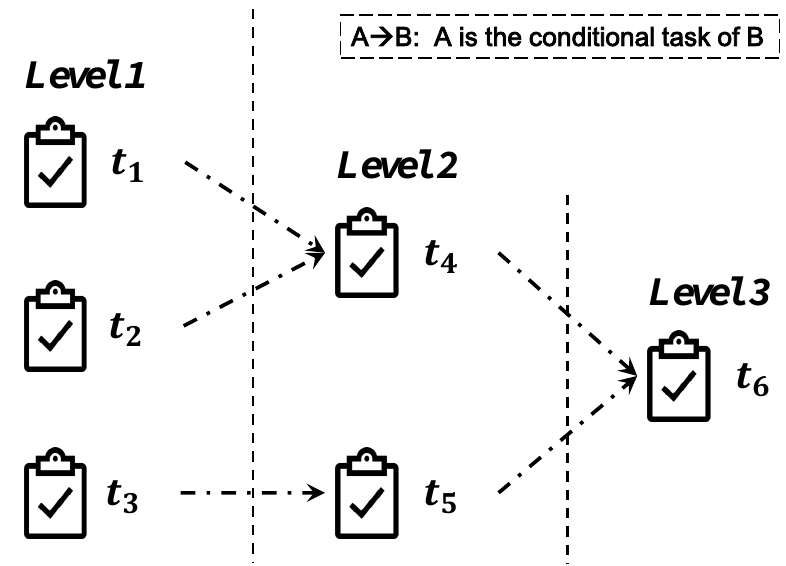
Figure 2. The instance for Algorithm 1.